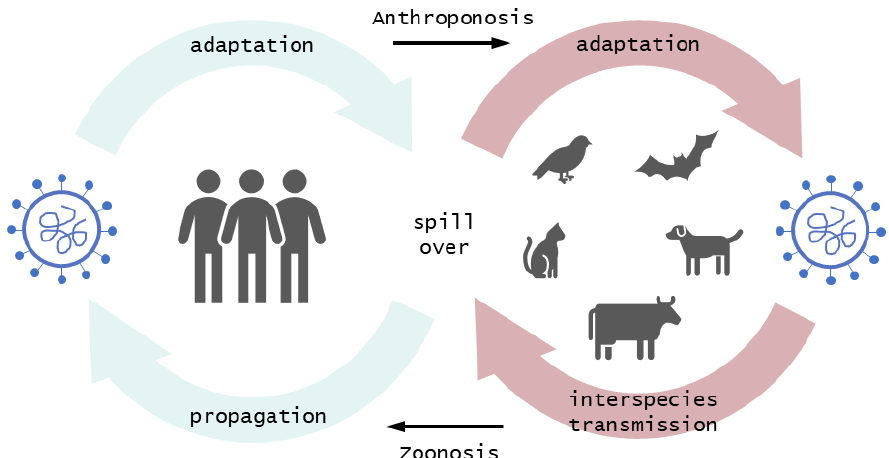
Figure 2. Transmission pathways between humans and animals (image created in Microsoft PowerPoint 2019).